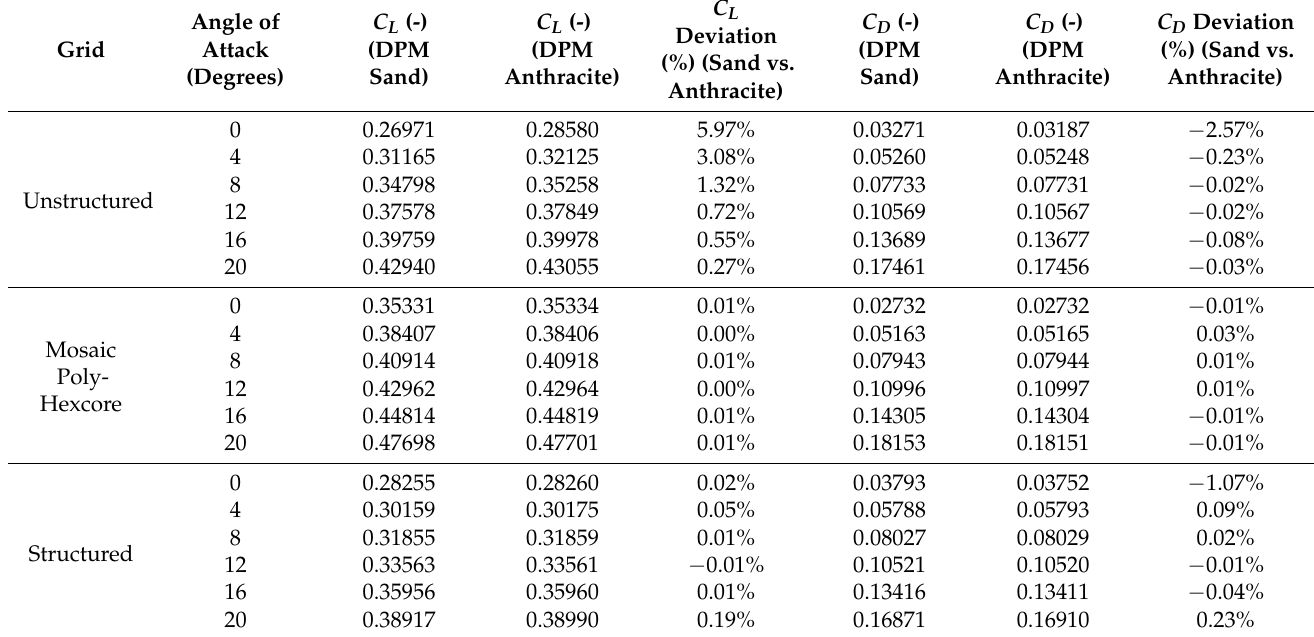
Table 4. Lift and drag coefficients of two-phase flow with sand and anthracite and their percentage deviation, for the three